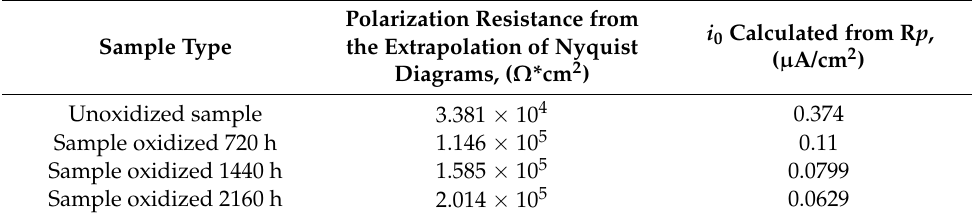
Table 5. Rp values established by Nyquist diagram extrapolation and the corrosion density current calculated from Buttler–Volmer